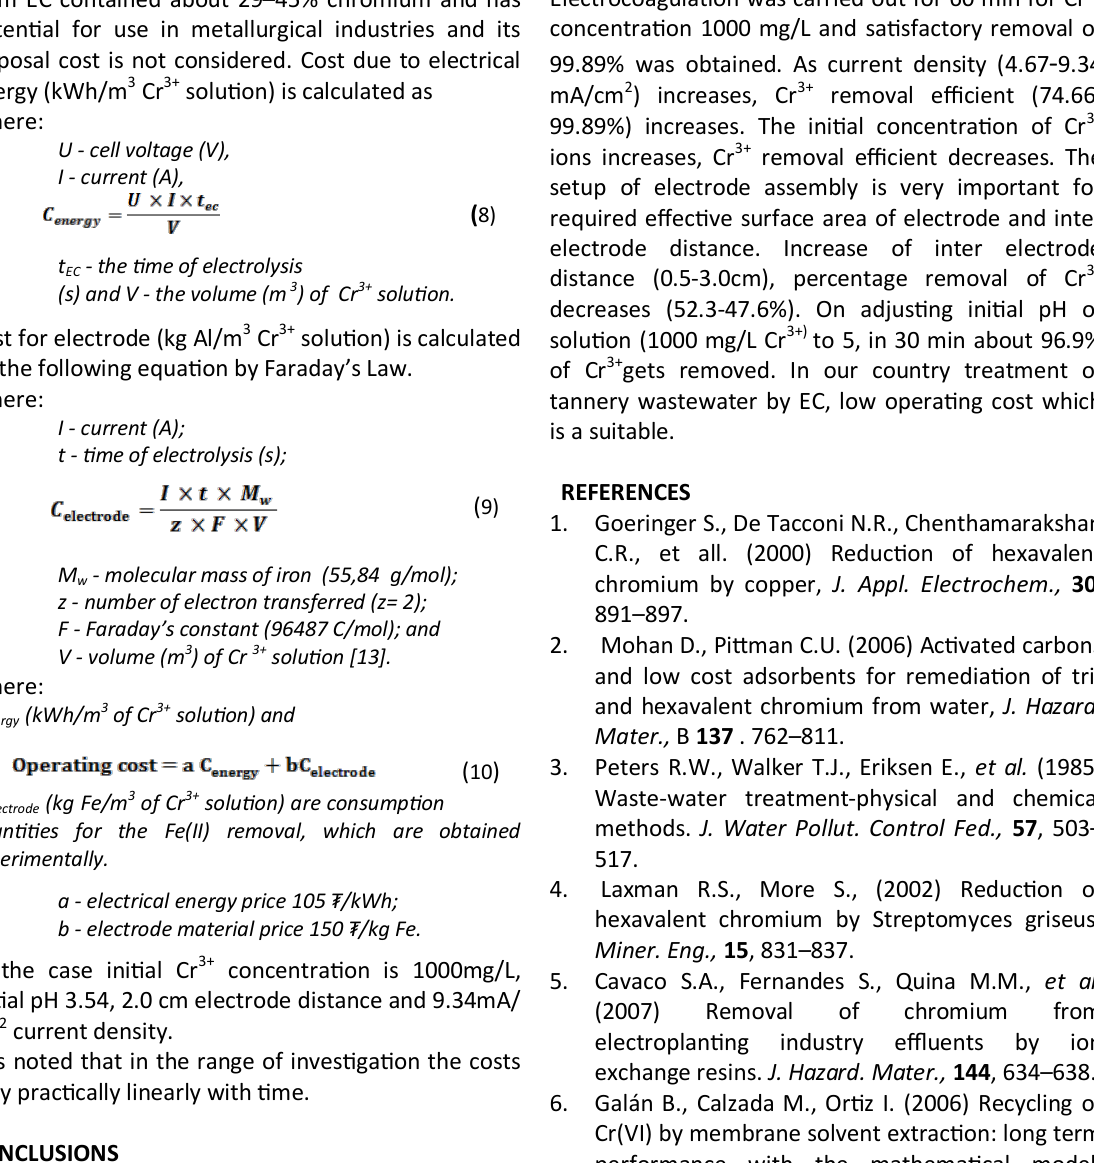
electrode distance, effect of pH were studied in detail.